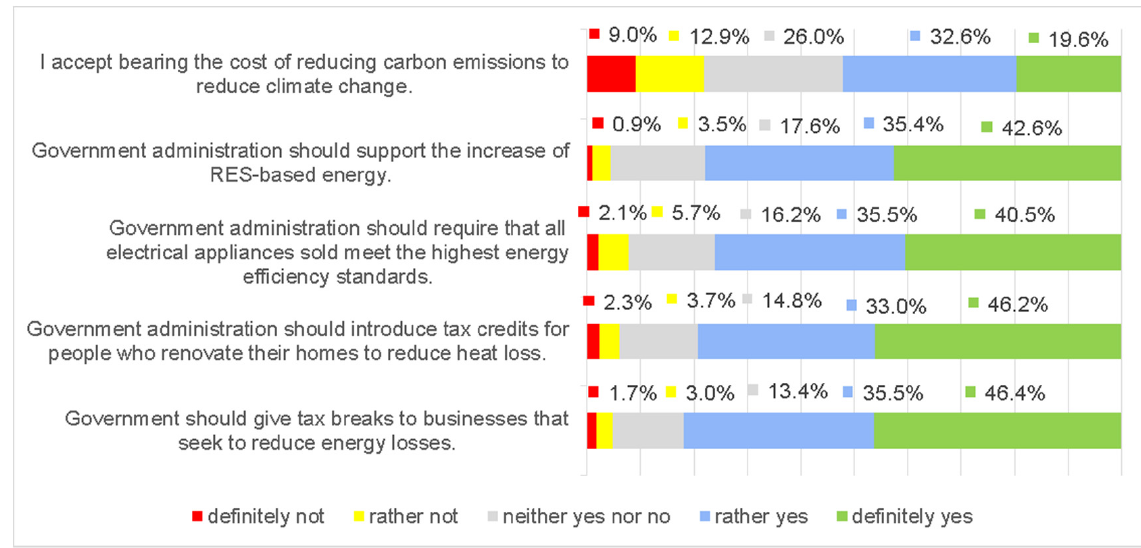
Figure 7. Structure of the assessment of theses diagnosing the expectations of respondents regarding activities related to energy conservation.